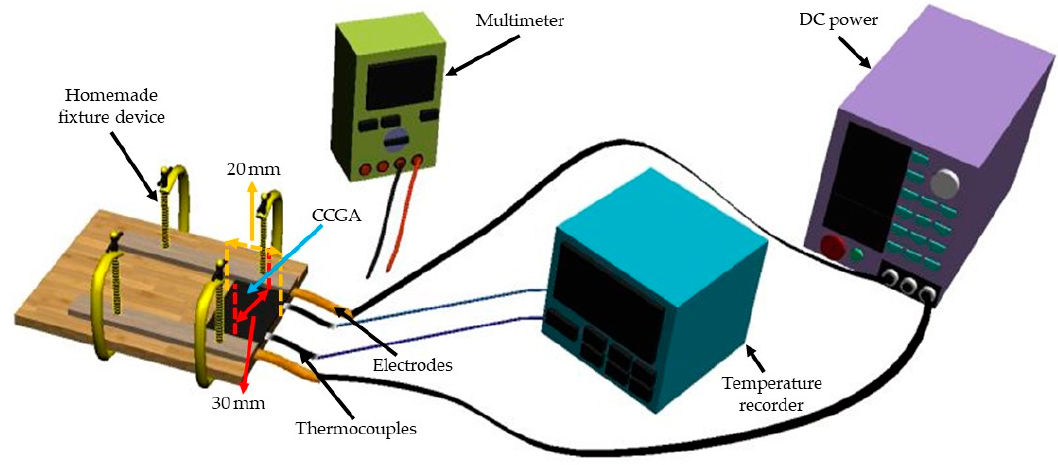
Figure 2. Test device for electric heating performance.